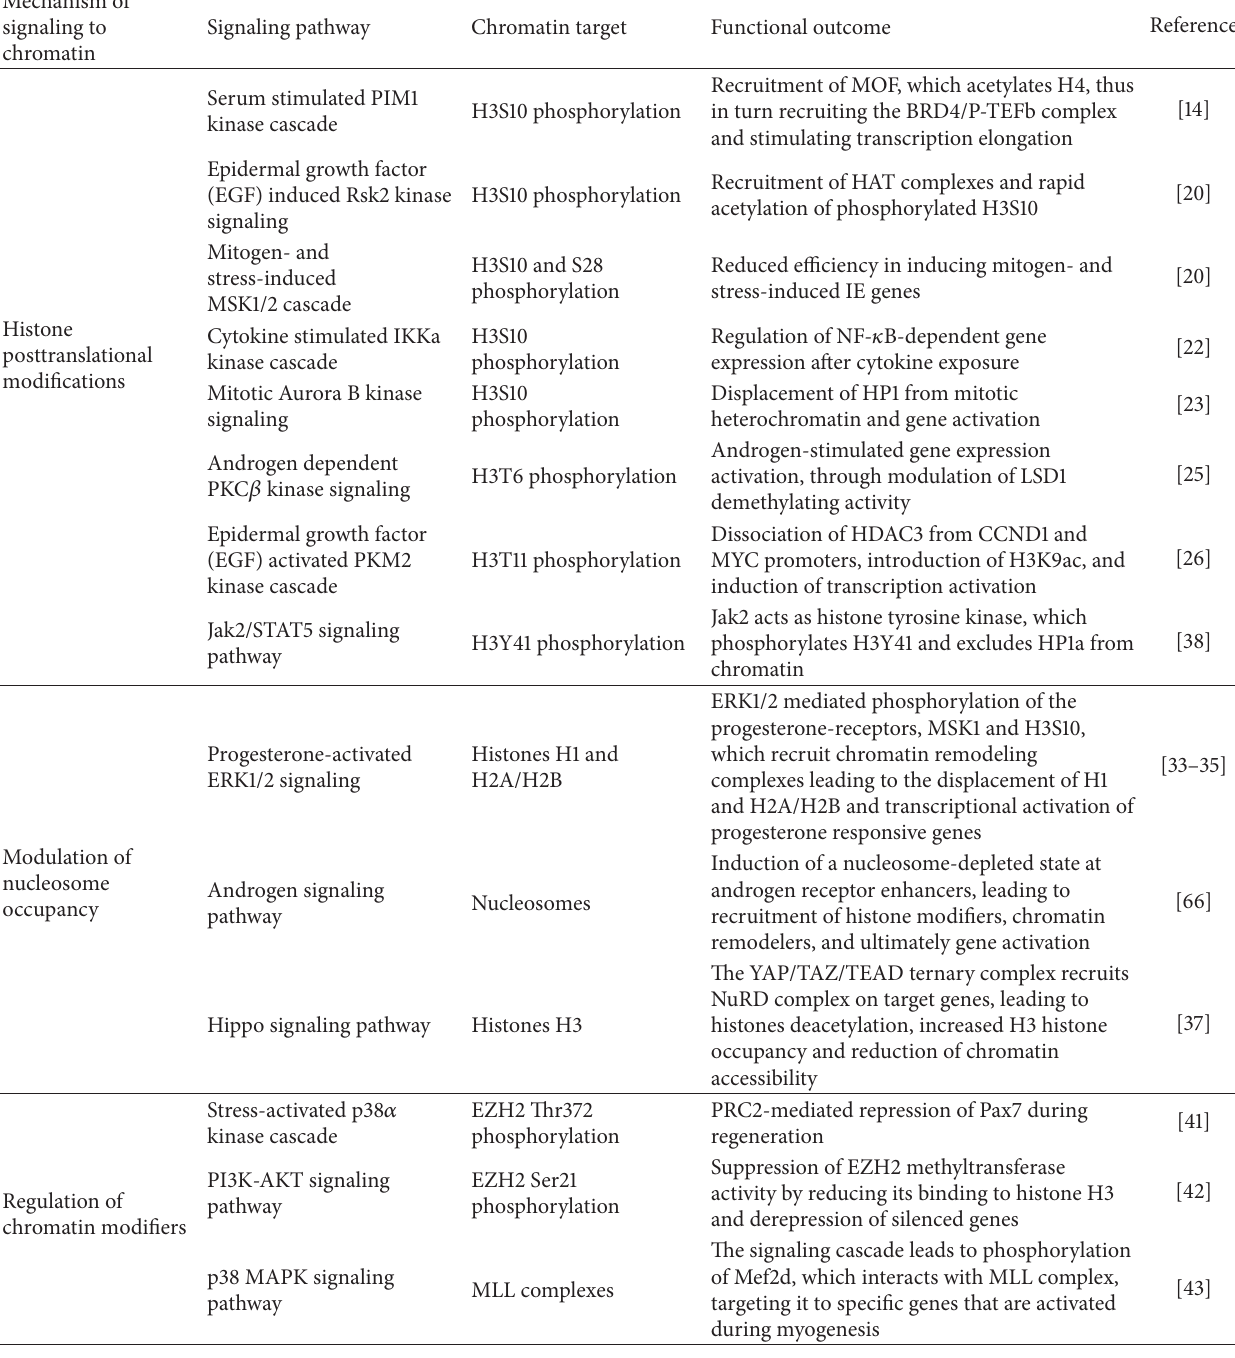
Table 1: Summary of different mechanisms of signaling to